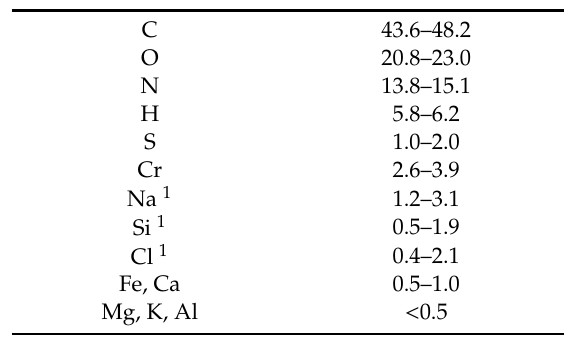
Table 1. Elemental composition of tested waste (%(w / w) in dry